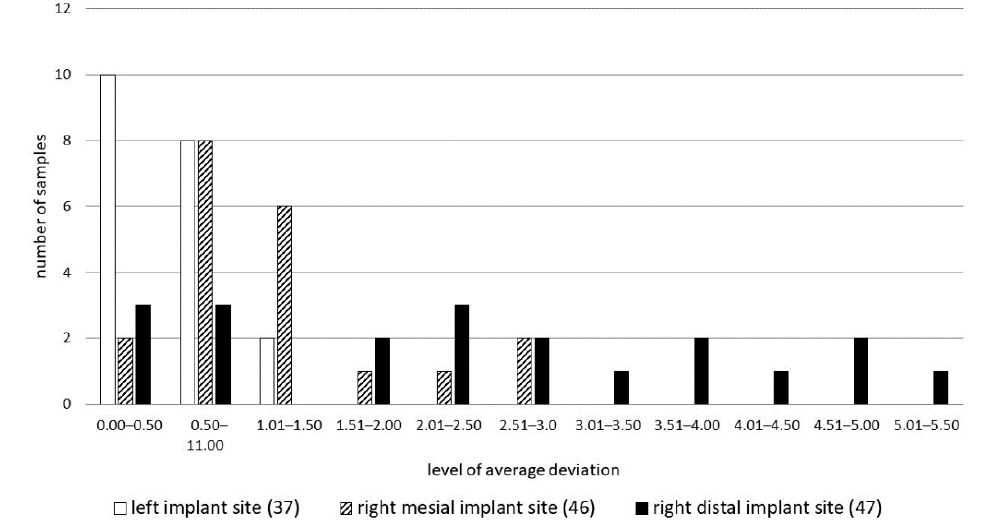
Figure 6. Number of samples in which average deviation (AD) is in the specified level of average